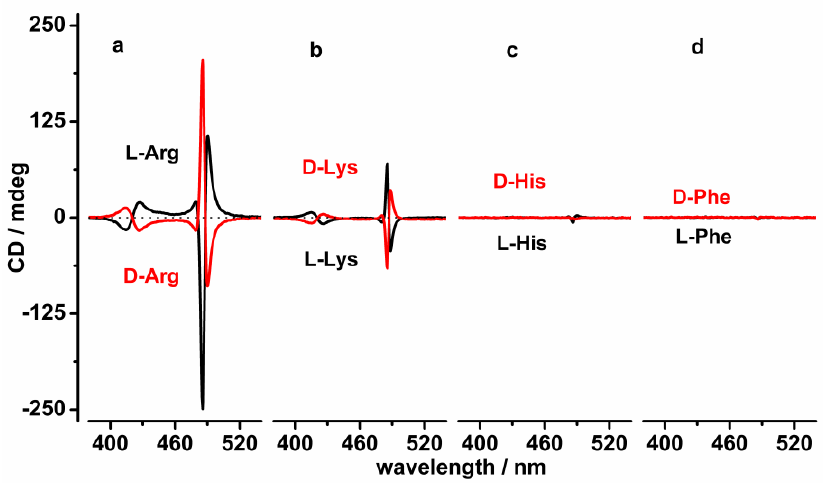
Figure 1. The CD spectra of the J-aggregates obtained with the protocol “acid first” template on: ( a ) 1 mM Arg; ( b ) 1 mM Lys; ( c ) 1 mM His; and, ( d ) 1 mM Phe (black curves represent the L- amino acids and red curves represent the D- amino acids).